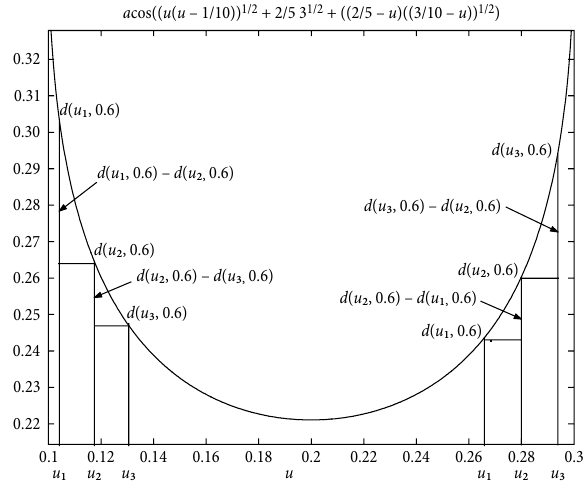
Fig. 4. Figure of function d ( u ,